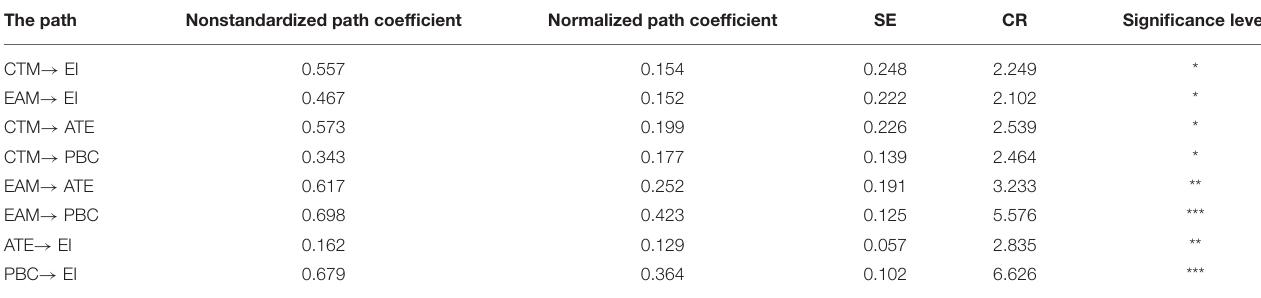
TABLE 6 | Results of path analysis and hypothesis testing. The path